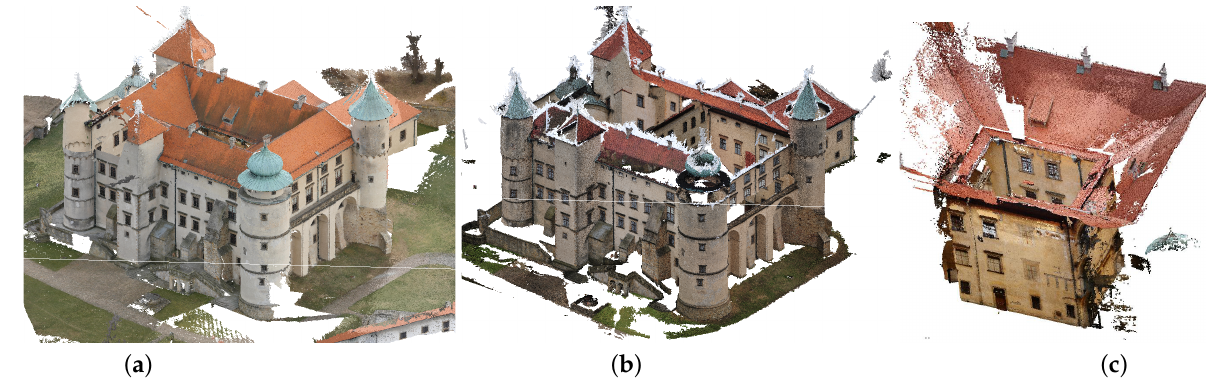
Figure 12. Combining reconstructions of the castle: from a UAV ( a ); from terrestrial photographs ( b ); the inner courtyard ( c